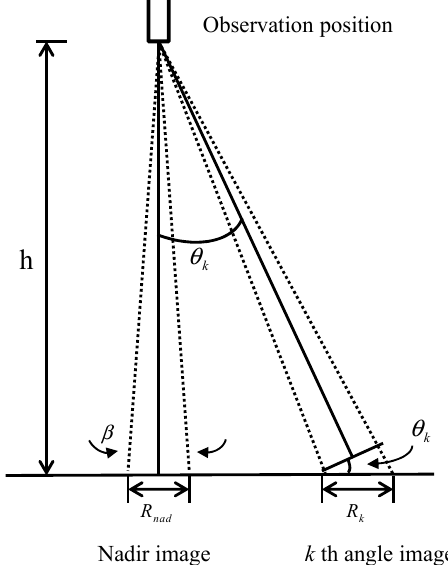
Figure 2. Illustration of a multi-angle imaging